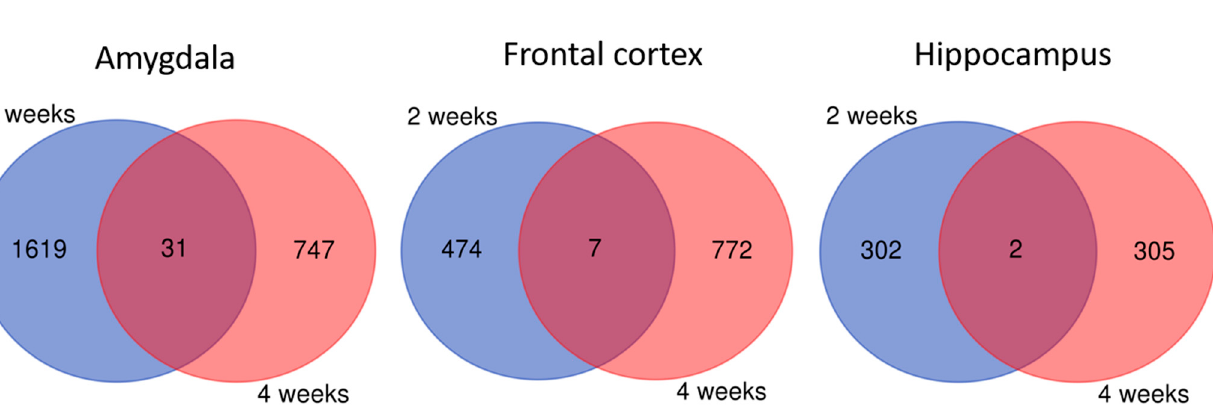
Figure 4. Genes differentially expressed in rats depressive-like after 2 weeks and 4 weeks on lithium treatment in the amygdala, frontal cortex and hippocampus. Shared genes between these time points were indicated by purple color.